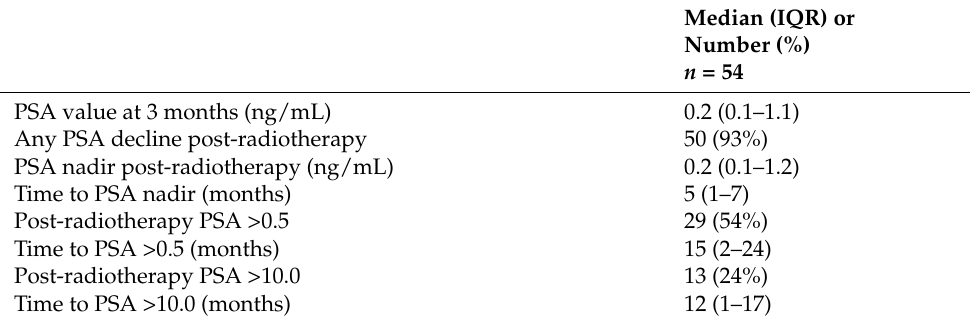
Table 3. Post-treatment prostate specific